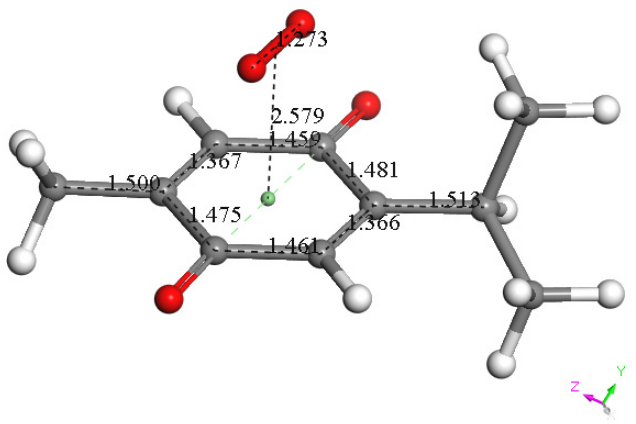
Figure 12. A cyclovoltammogram of a blank experiment using a classical one working electrode, is taken from [24], where meaning of red lines are described.